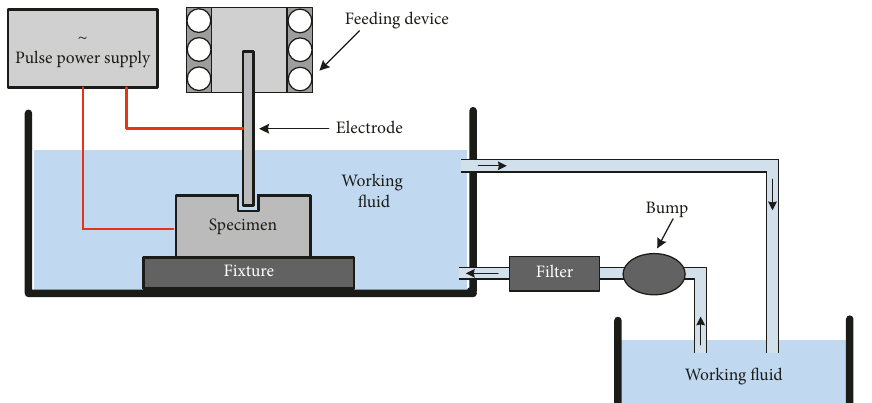
Figure 5: Diagram of crack prefabrication.